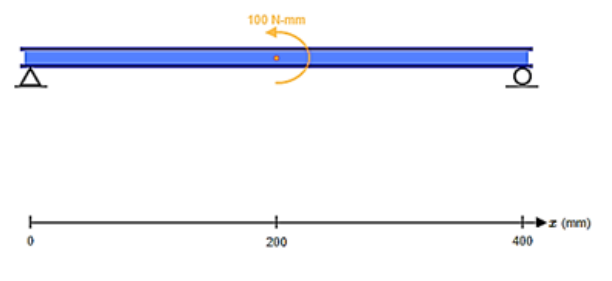
Fig. 4. Simply supported beam with moment load applied at the middle